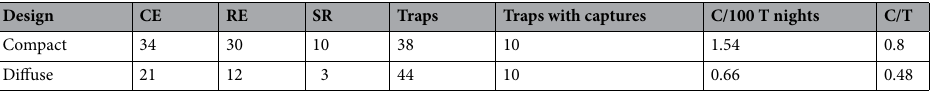
Table 1. Summary of snow leopard photo-captures in Hunza-Nagar districts, Gilgit-Baltistan, Pakistan, during two camera trapping sessions. C captures, T traps, CE capture events, RE recapture events, SR spatial recapture events.